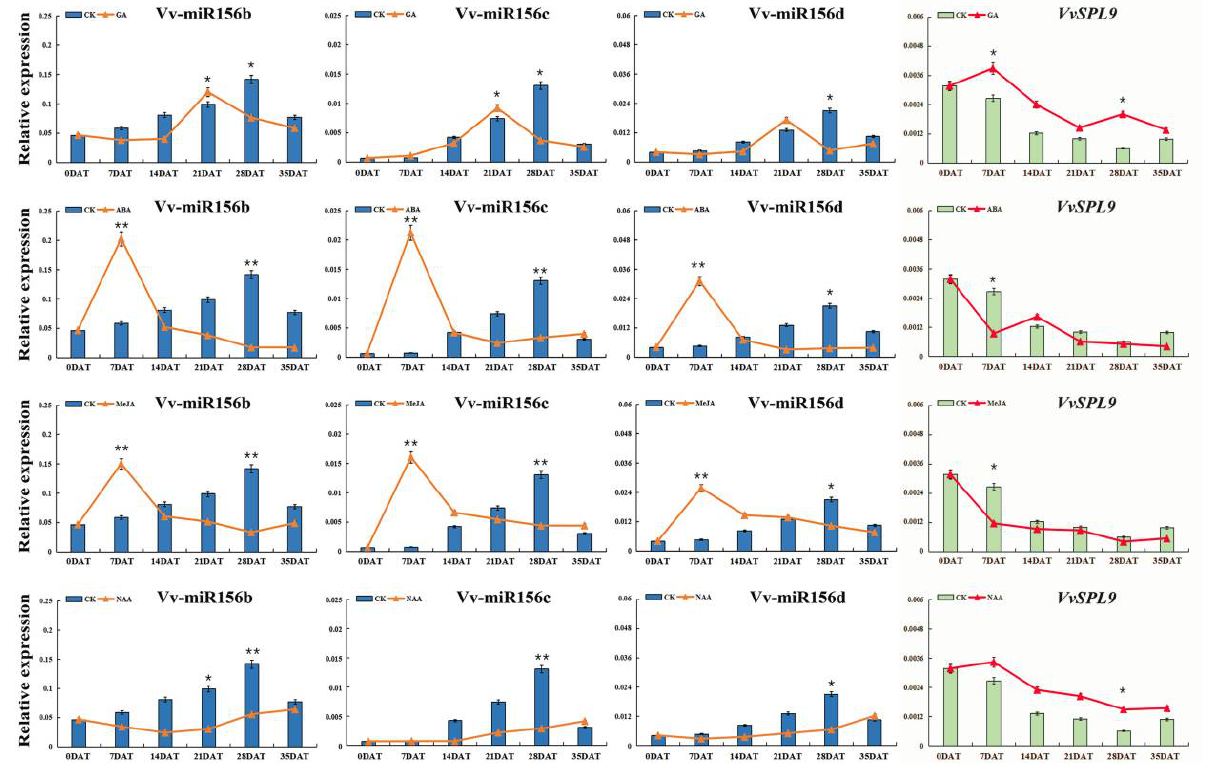
Figure 5. Differential expression of VvmiR156b/c/d and their VvSPL target genes in response to different hormone treatments at different time points [seven days after treatment (7DAT), 14DAT, 21DAT, 28DAT, 35DAT] of berry development. Asterisks indicated statistically significant differences at (* p < 0.05; ** p < 0.01) as determined